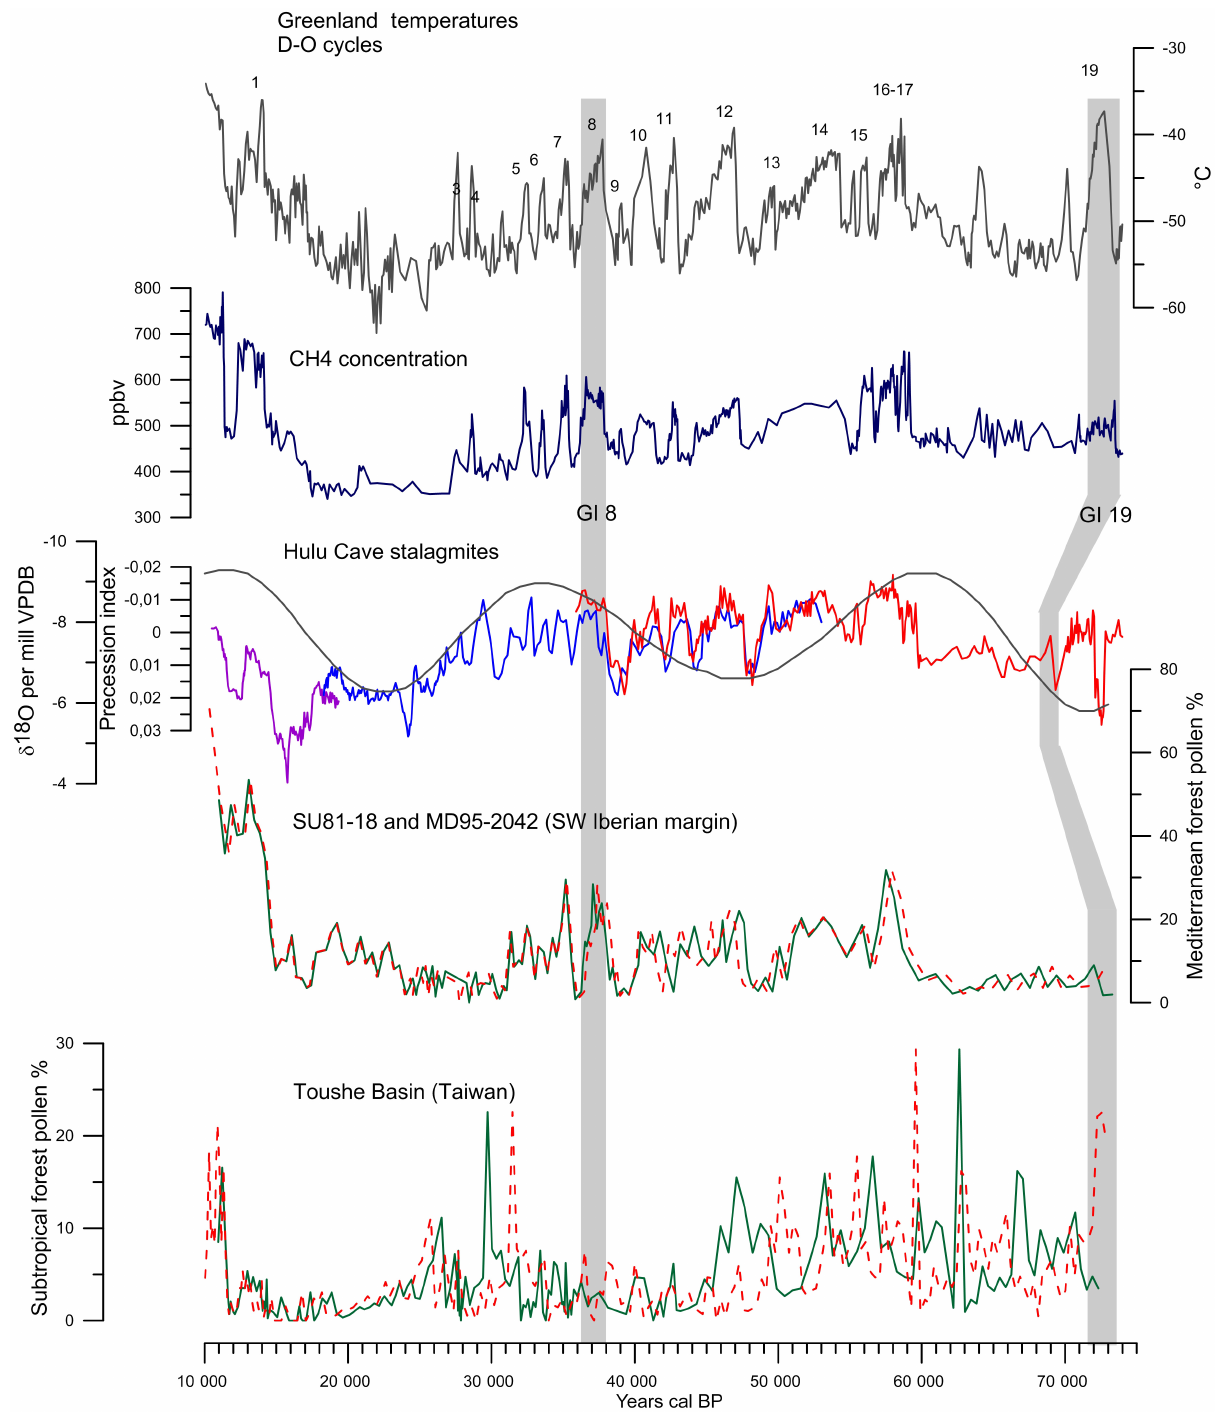
Figure 6. Comparison of pollen sequences from the Toushe Basin (Taiwan) and the SW Iberian margin (cores MD95-2042 (Desprat et al., 2015; Sanchez Goñi et al., 2008) and SU 81-18 (23500–10000calyearsBP) (Lézine and Denèfle, 1997)) for the interval 73–23.5ka. Green line: new harmonized age model; dashed red line: original age model. Grey vertical bands indicate the duration of GI 8, GI 16–17 and GI 19. Also shown are the comparison with the Greenland temperature record (black) (Huber et al., 2006; Landais et al., 2005; Sanchez Goñi et al., 2008), the atmospheric CH 4 concentration (blue) record (Chappellaz et al., 1997; Flückiger et al., 2004), compiled Hulu Cave δ 18 O speleothem records (PD in purple, MSD in green and MSL in blue) (Wang et al., 2001) and the precession index (Laskar et al., 2004). Note the mismatch in the timing of GI 19 between the Greenland and pollen harmonized age models and the chronology of Hulu Cave.